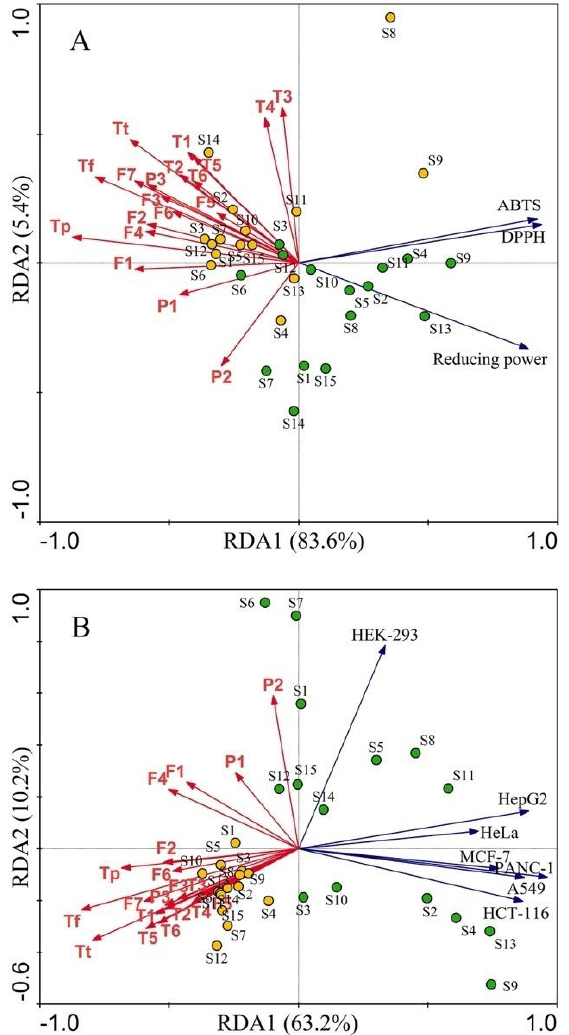
Figure 3. Redundancy Analysis (RDA) ordination diagram of bioactive metabolites and antioxidant activity ( A ), bioactive metabolites and antiproliferation effects on cells ( B ). The yellow and green circles represent the ethanol and water extracts of C. paliurus population samples, respectively.